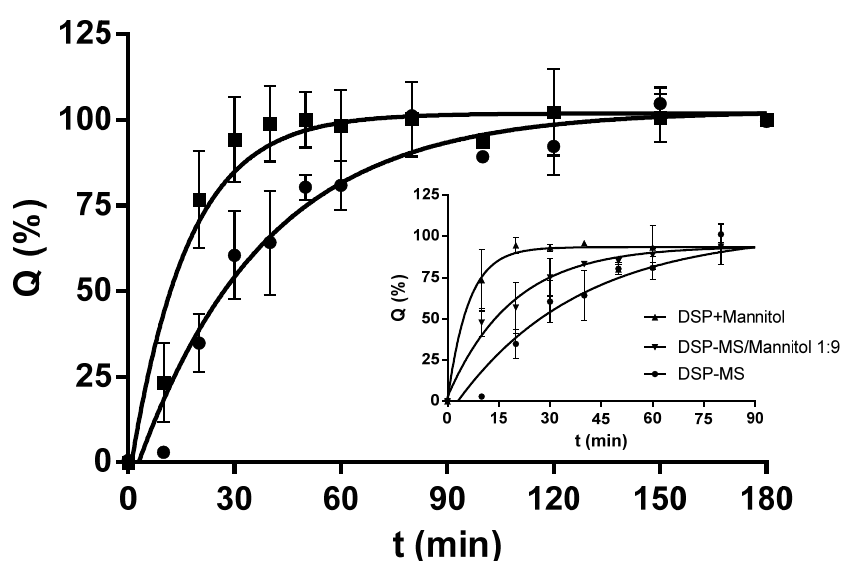
Figure 4. In vitro release profile of DSP from DSP-MS microspheres (circle) compared to dissolution of pure DSP powder (square). Graph insert: DSP in vitro release profile from DSP-MS microspheres blended with inert carrier (DSP-MS/Mannitol 1:9, w/w ; reversed triangle) compared to dissolution of DSP from corresponding DSP/inert carrier blend (DSP + Mannitol; triangle). Q represents cumulative percentage of DSP released at time t . Data are expressed as the mean ± SD ( n = 3).